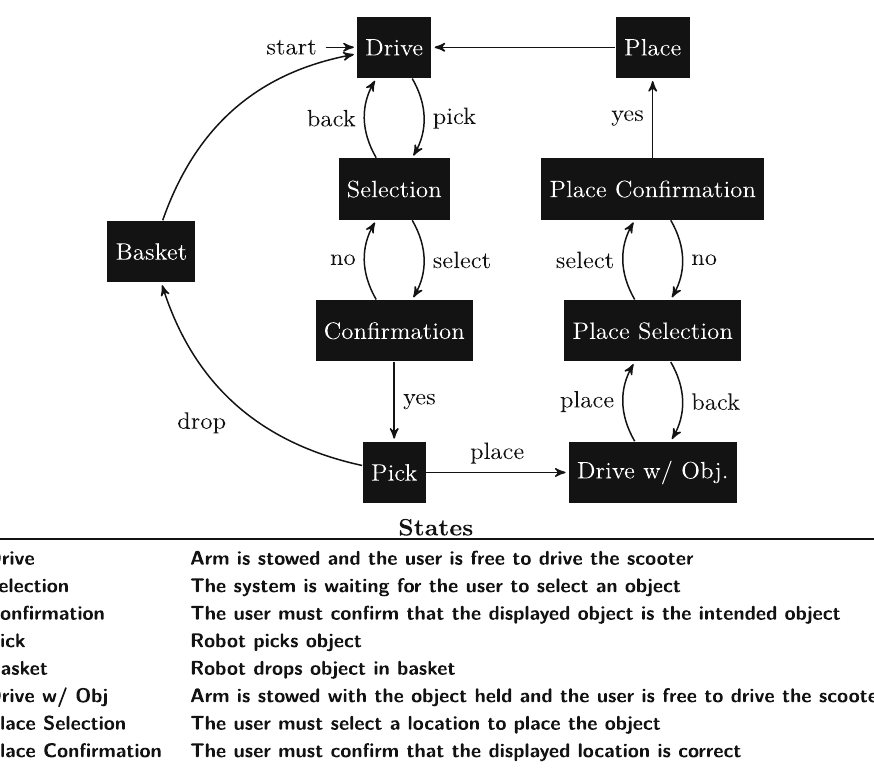
Figure 3: State diagram for the robot task. Users of the system select an object for the robot arm to pick up, then decide whether to place the object in a new location or have it dropped into a basket on the